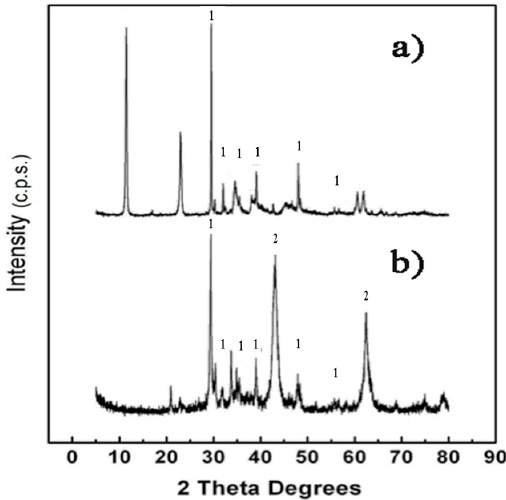
Figure 1. X-ray diffraction pattern of hydrotalcite samples: ( a ) before calcination at 600 °C; ( b ) after calcination at 600 °C. Peaks (1) and (2) correspond to sodium nitrate and Mg–Al oxides (periclase), respectively; c.p.s.: counts per second.